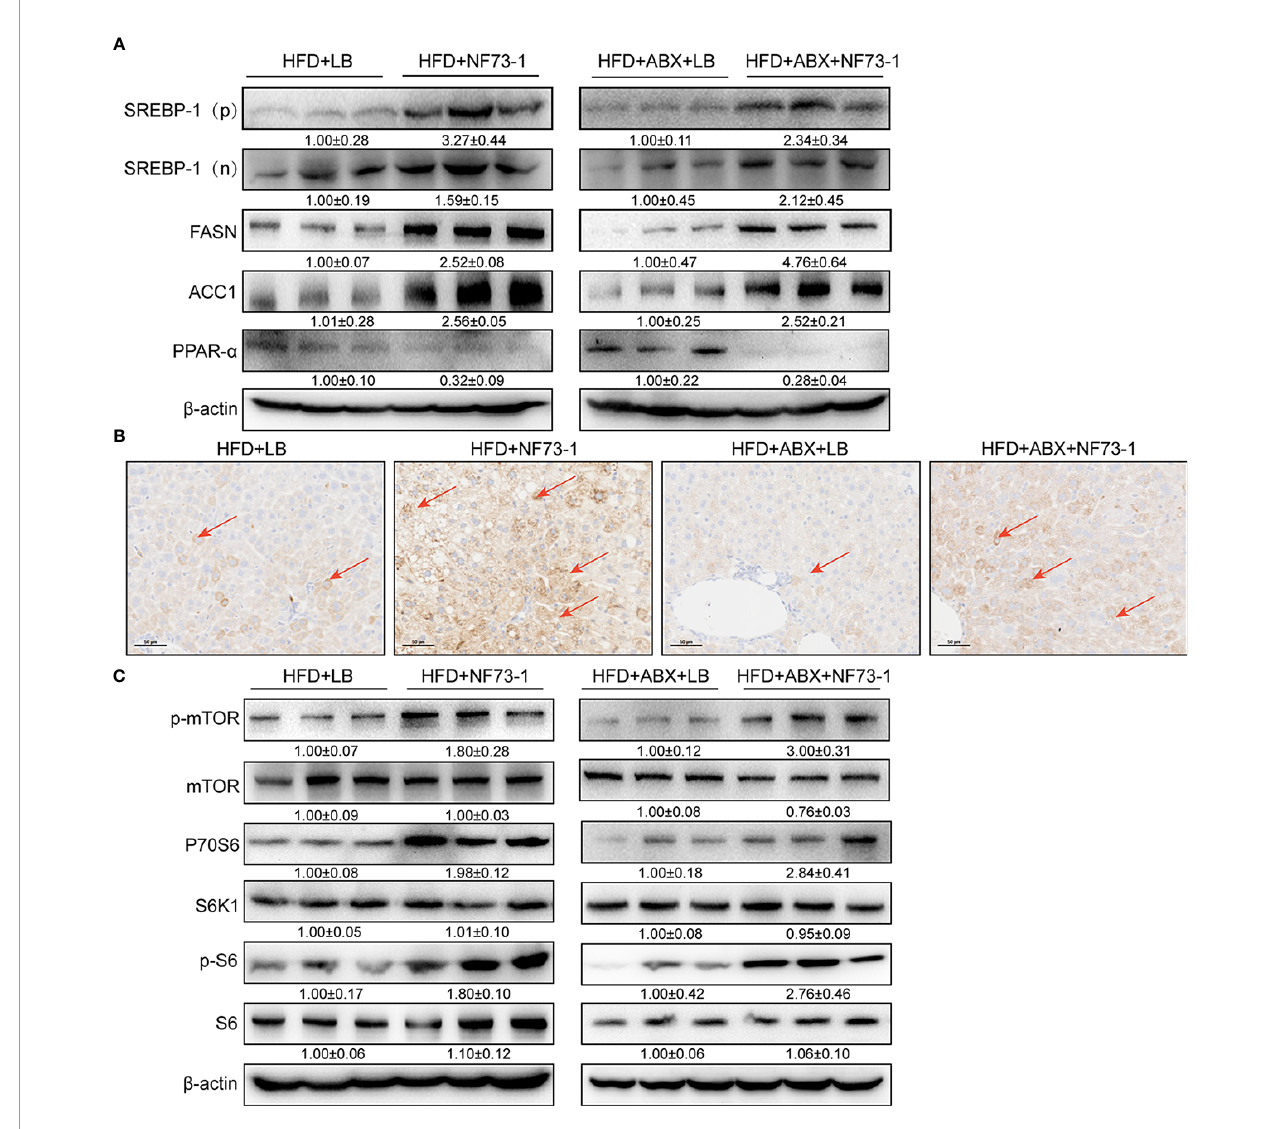
FIGURE 7 | Activation of mTOR signaling and promotion of NAFLD in E. coli NF73-1 – fed mice. (A) Increasing nuclear translocation of SREBP-1(N) and expression of SREBP-1 (P), as well as its targets, such as ACC1 and FASN, after E. coli NF73-1 treatment and decreasing PPAR- a expression after E. coli NF73-1 treatment. (B) Positive immunostaining for phosphorylated S6 (brown color), the predominant location in lipid-rich hepatocytes (red arrows) of NAFLD mice. (C) Representative immunoblots of phosphorylation of mTOR, S6K1, and S6 in livers from three mice in each group. Total liver lysates of the indicated genotypes were subjected to western blot analysis and densitometry analysis. Data are means ± SEM (n = 3). NAFLD, non-alcoholic fatty liver disease; mTOR, mammalian target of rapamycin; N, cleaved nuclear (68 kDa) form of SREBP-1; P, precursor (125 kDa) form of SREBP-1; S6K1, S6 kinase 1; SREBP-1, sterol-regulatory element binding protein-1; ACC1, acetyl-coenzyme A carboxylase; FASN, fatty acid synthase; PPAR- a , peroxisome proliferator-activated receptor